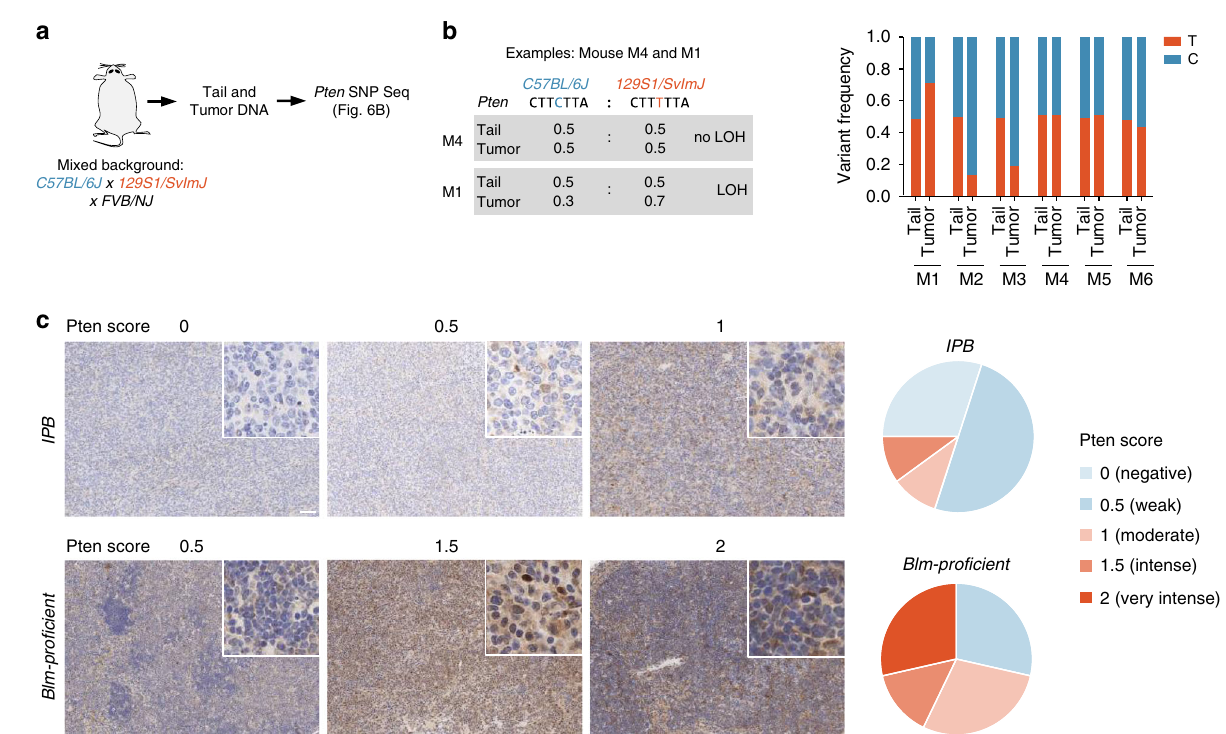
Fig. 6 Loss of heterozygosity analysis in tumors from IPB mice. a Loss of heterozygosity (LOH) analysis work fl ow. Fragment of Pten containing the single nucleotide polymorphism (SNP) rs30424206 was ampli fi ed and sequenced in tumors and tails from ITP2-M;Rosa26 PB/ + ; Blm m3/m3 (IPB) mice ( n = 10). b Variant frequencies determined by Pten SNP sequencing of tail and tumor tissue samples from six IPB mice. All tumors harbored high-coverage Pten insertions. c Pten IHC of tumors from IPB mice ( n = 10), as well as from DLBCLs generated in a Blm -pro fi cient screen using ATP2-S1;Rosa26 PB/ + mice ( n = 7). Pten expression was scored semi-quantitatively. Representative microscopic images are shown. Pie charts display proportions of tumor samples with different Pten expression scores. Scale bar, 50 µ m; Insets, ×200 magni fi